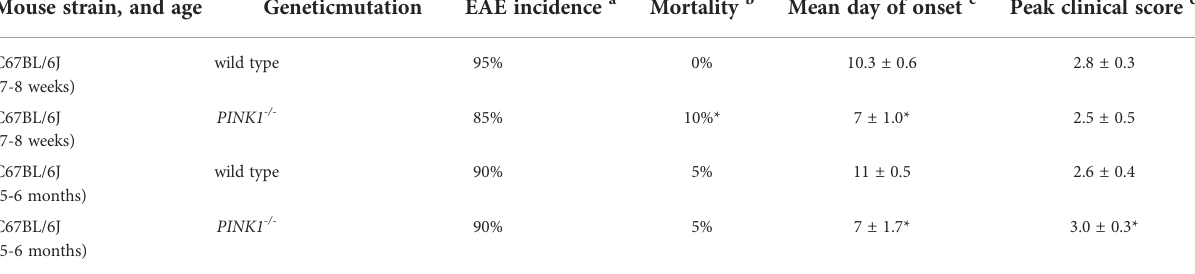
TABLE 1 Age-related differences on disease course in MOG 35-55 -induced